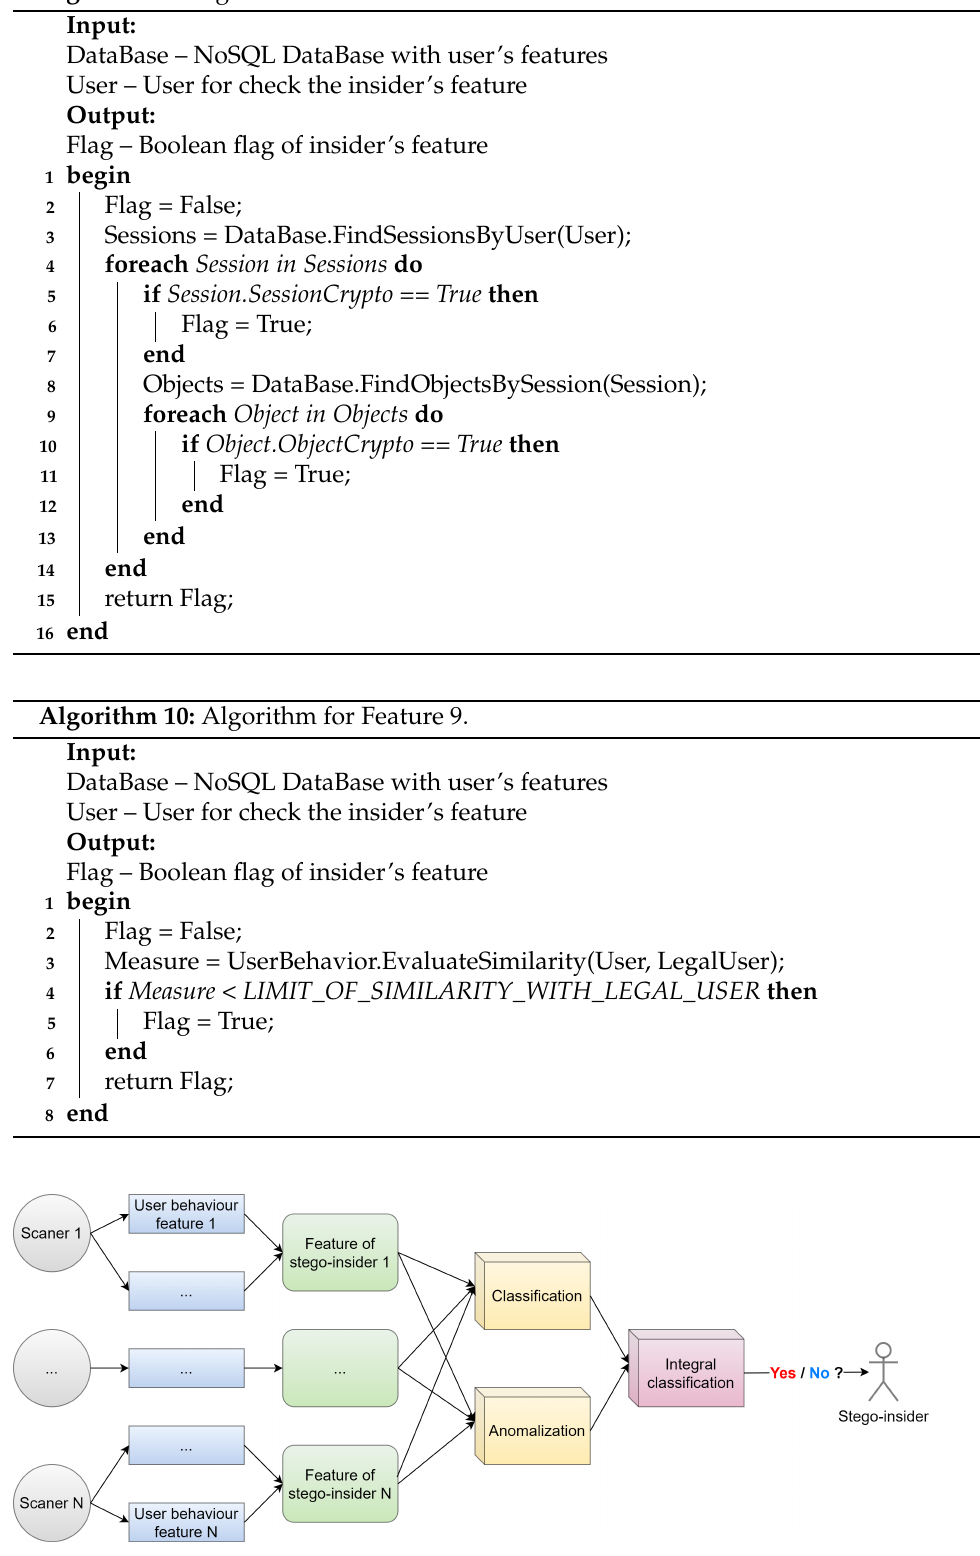
Algorithm 9: Algorithm for Feature 8.